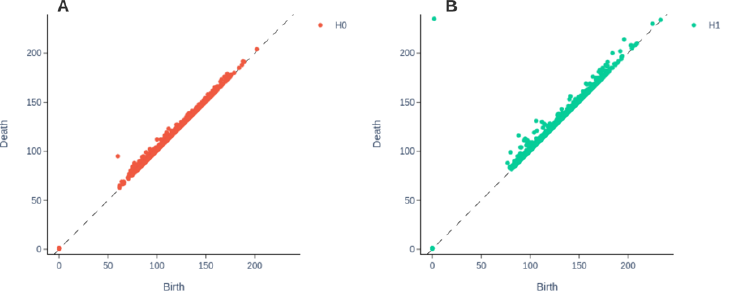
Figure 9. Persistence diagrams (PDs) corresponding to barcodes in Figure 6. Notice that the same information is presented in a more understandable manner, where the diagonal line represents the birth value and the points above the diagonal represent the dead value of a given topological characteristic. PDs facilitate the identification of noise versus relevant topological characteristics.